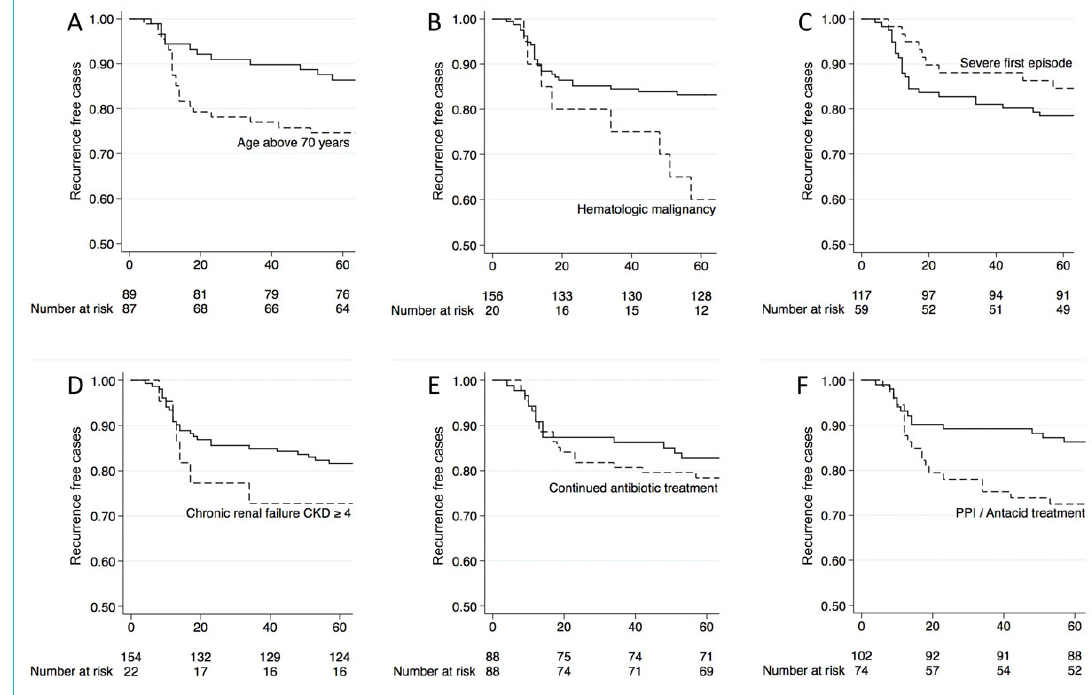
Figure 2: Kaplan-Meier curves showing Clostridioides difficile infection (CDI) recurrence after first episode according to risk factors (shown with the dashed line) of recurrence. A: age >70 years; B: haematological malignancy / leukaemia; C: severe first episode; D: chronic renal